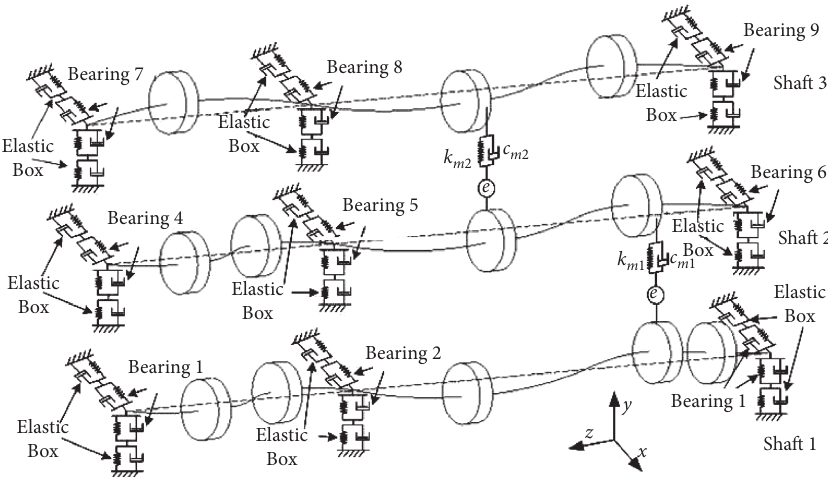
Figure 3: Mechanical model diagram of gear Table 3: Bearing stiffnesses.